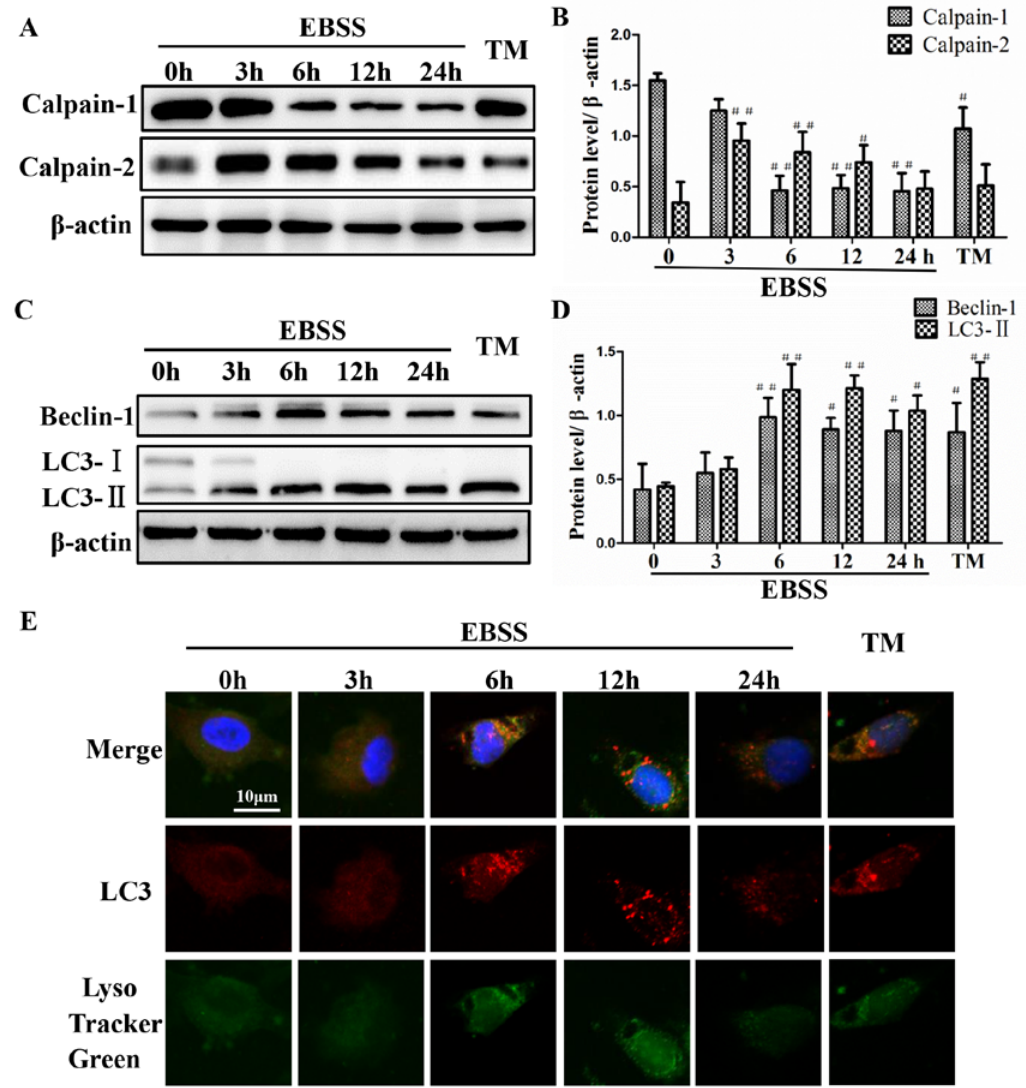
Figure 2. Earle’s balanced salt solution (EBSS) increases calpain activity and autophagy in ARPE-19 cells in a time-dependent manner. ( A , B ) Western blot analysis was performed to detect the expression levels of calpain-1 and calpain-2 in ARPE-19 cells. ( C , D ) Autophagy was evaluated by detecting LC3-II expression with immunoblots. ( E ) The colocalization of LC3 and LysoTracker Green in ARPE-19 cells. Scale bar = 10 μm, TM stands for tunicamycin. # p < 0.05, ## p < 0.01 compared with control (0 h).